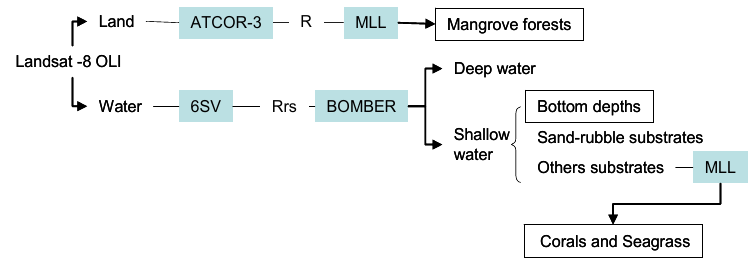
Figure 2. Satellite image processing scheme adopted in this study for mapping mangroves, corals, and seagrass habitats.